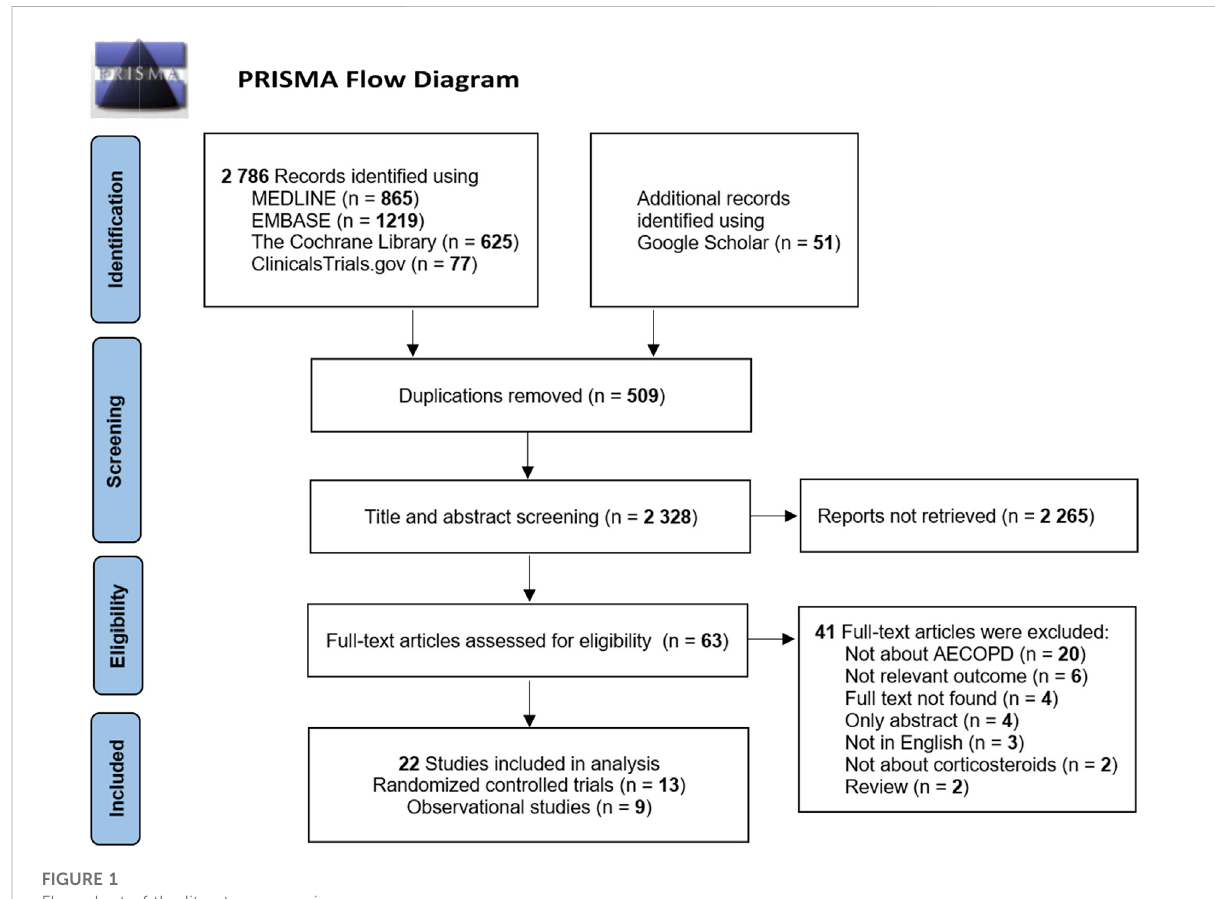
Flow chart of the literature screening